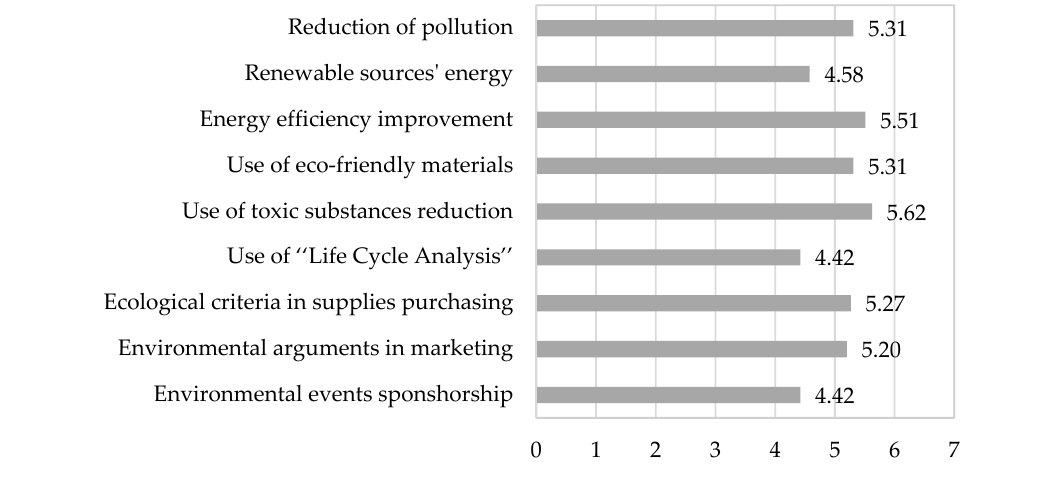
Figure 3. Environmental product innovation.